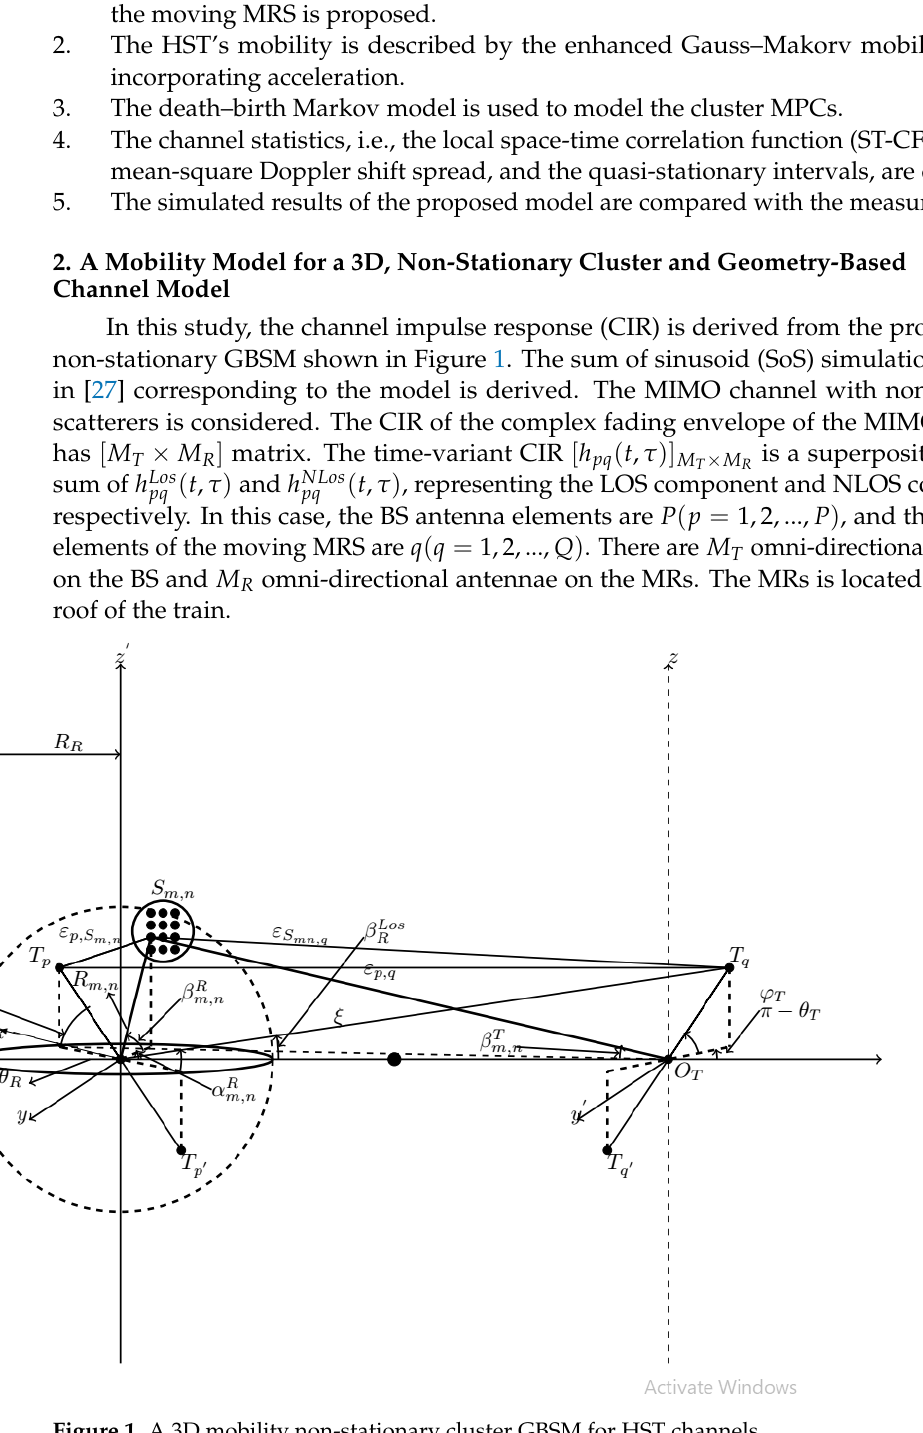
Figure 1. A 3D mobility non-stationary cluster GBSM for HST